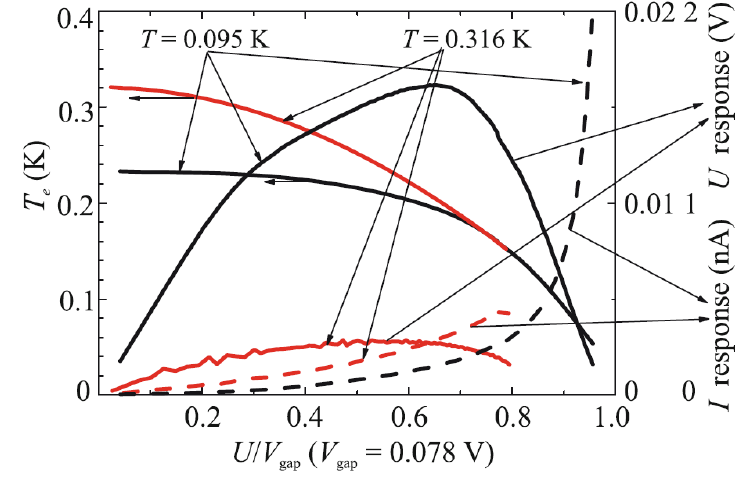
Figure 3. Voltage dependences of the electron temperature of the normal absorber of the detector (left scale) and of the voltage and current responses (right scale) at temperatures of (0.095 ± 0.01) K and (0.316 ± 0.02) K when irradiated with a black body radiation source. Red lines show the results for the temperature of the sample holder T = 0.32 K, with black lines for the temperature T = 0.1 K. Solid lines belonging to the right scale show voltage responses, while dotted lines show current responses. Graph from [30].